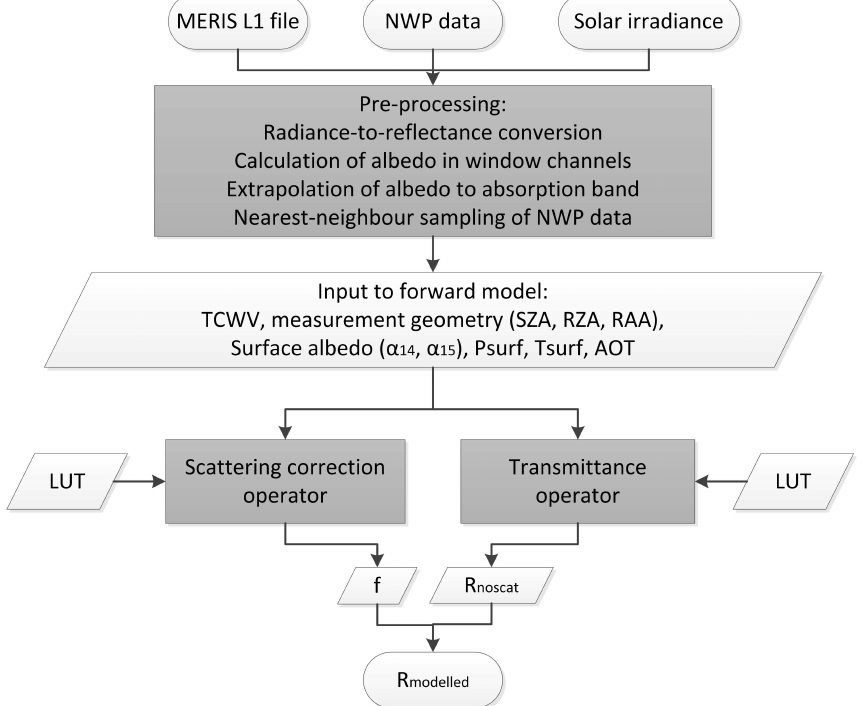
Fig. 6. Flow chart of forward modelling process.